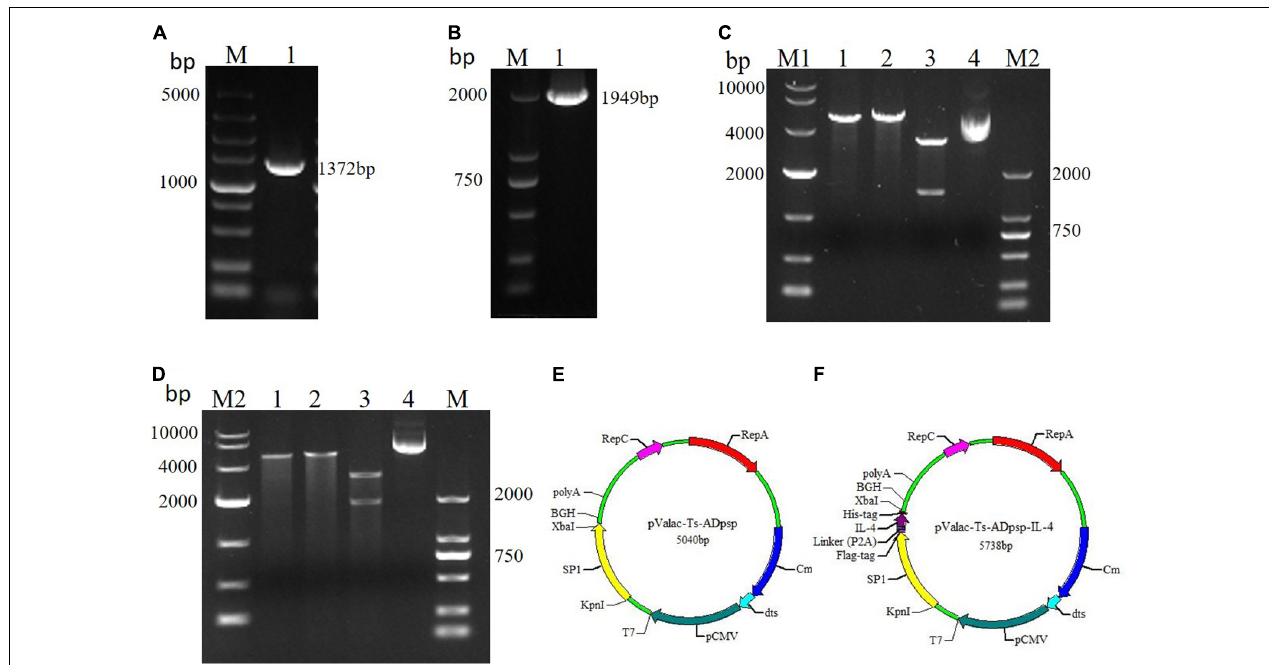
FIGURE 1 | Construction of recombinant plasmids pValac-Ts-ADpsp and pValac-Ts-ADpsp-IL-4. (A) Expression of the Ts-ADpsp gene in the tongue muscles of mice challenged with T. spiralis muscle larvae. (B) PCR amplification of the Ts-ADpsp-IL-4 fragment. (C) Identification of the Ts-ADpsp insert in plasmids extracted from randomly picked pValac-Ts-ADpsp colonies after Cm selection. Lane 1: plasmids digested with Kpn I; lane 2: plasmids digested with Xba I; lane 3: plasmids digested with Kpn I/ Xba I; lane 4: pValac-Ts-ADpsp plasmid. (D) Identification of the Ts-ADpsp-IL-4 insert in plasmids extracted from randomly picked pValac-Ts-ADpsp-IL-4 colonies after Cm selection. Lane 1: plasmids digested with Kpn I; lane 2: plasmids digested with Xba I; lane 3: plasmids digested with Kpn I/ Xba I; lane 4: pValac-Ts-ADpsp-IL-4 plasmid. Genes encoding Ts-ADpsp and Ts-ADpsp-IL-4 were inserted into the pValac vector, producing pValac-Ts-ADpsp (E) and pValac-Ts-ADpsp-IL-4 (F) ,